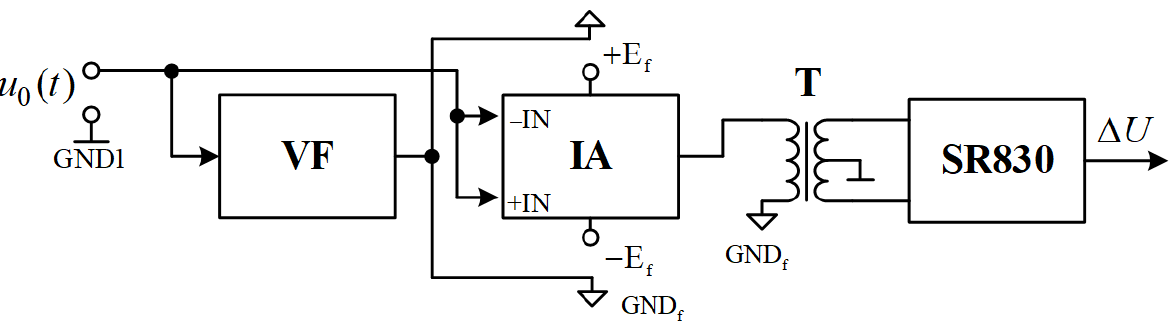
Figure 6. Prototype of differential signal recovery.